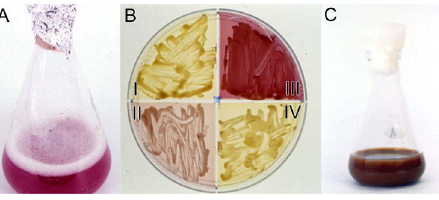
Figure 1. Pink and brown pigment production by Cryptococcus . The intensity of the pink and brown pigments were estimated visually. Strong pink pigment was produced in m-LTG media by C.neoformans var. grubii (A) C. gattii (B) formed light brown pigments on quadrants I and IV and C. neoformans var. neoformans and C. neoformans var. grubii produced pink pigments (quadrants II and III) respectively on m-LTG agar. The intensity of the pink pigment varied from strain to strain. Some strains of C. neoformans var. neoformans produced brown pigments on m-LTG agar (not shown). C. gattii produced an intense brown pigment after growth in m-FLTG medium